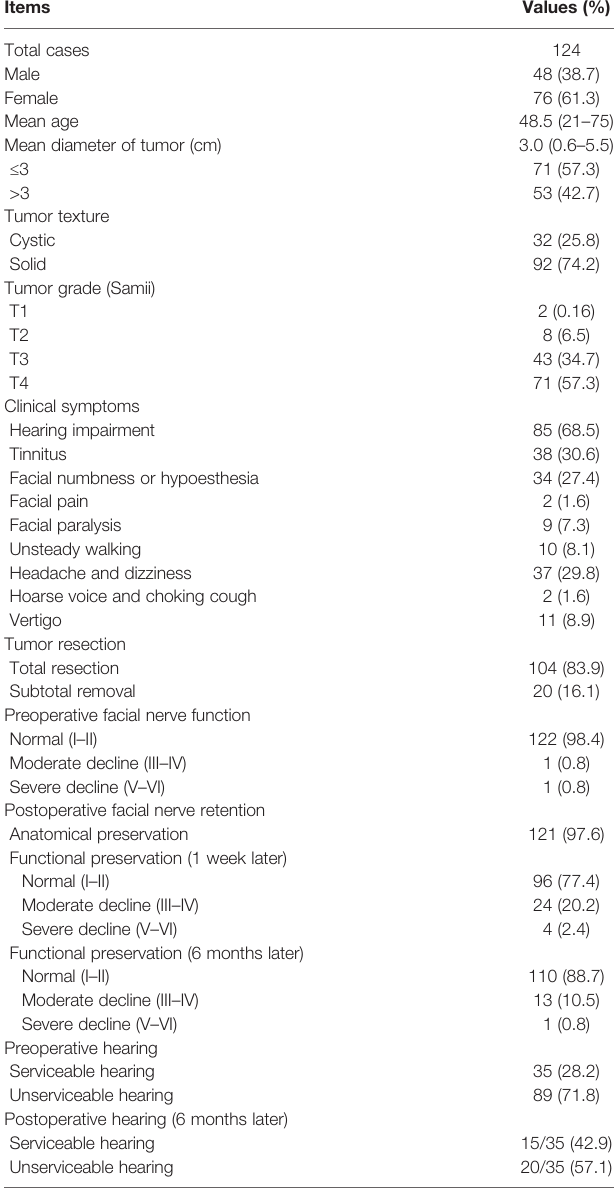
TABLE 1 | Clinical features of 124 patients with vestibular schwannoma.